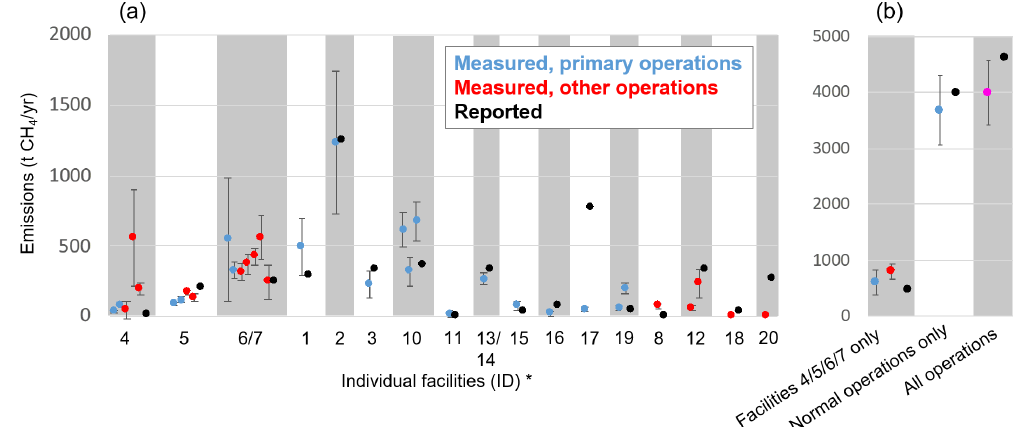
Figure 5. Facility-level CH 4 emissions (multiple data points per facility represent repeat surveys on different days). (a) Measured (red and blue) and facility-reported (black) CH 4 emission estimates by facility ID number. (b) Total emissions (based on average facility emissions for repeated surveys). The first column includes only facilities 4, 5, 6 and 7 (representing “other” operations). The second column represents all other facilities (representing “primary” operations). The third column represents all facilities collectively (magenta data point). Error bars represent 1 σ uncertainties. ∗ Facilities 6 and 7 and 13 and 14 were measured separately (and fluxes were added), but the operator reported a combined estimate. Facility 9 is not included here because it was reported inactive during 2019 and because measured CH 4 emissions were negligible (see Table